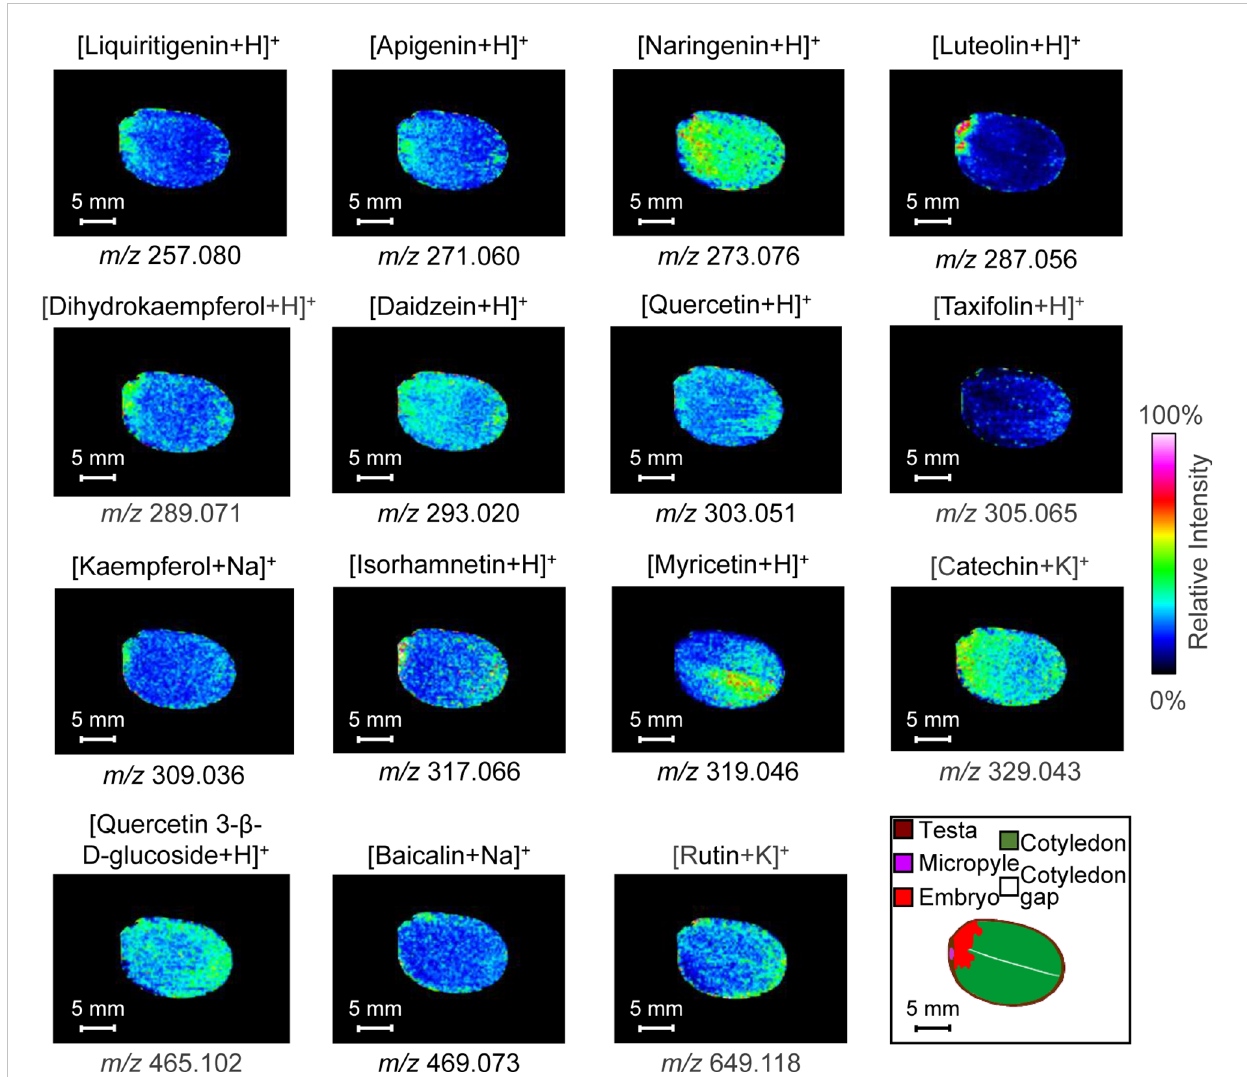
FIGURE 4 Ion images of 15 detectable fl avonoids in litchi seed tissue sections from MALDI-TOF-MS using 2-MBT as the matrix in positive ion mode. MS imaging was acquired at 250- m m spatial resolution. MALDI, matrix-assisted laser desorption/ionization; TOF, time of fi ght; MS, mass spectrometry; 2-MBT,